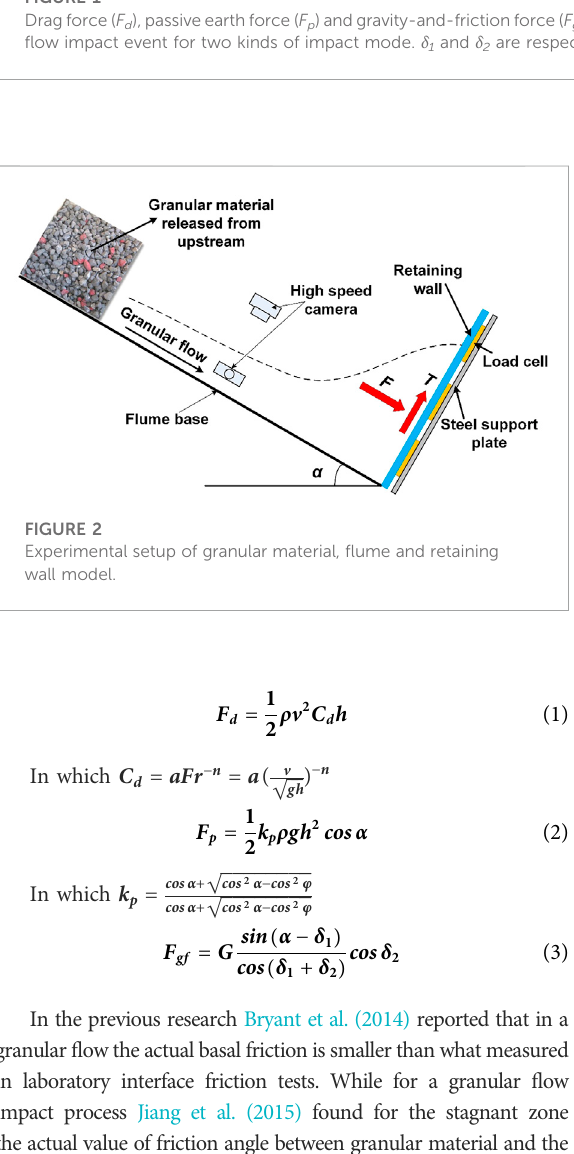
δ 1 and 2 are respectively the interface friction angles of the